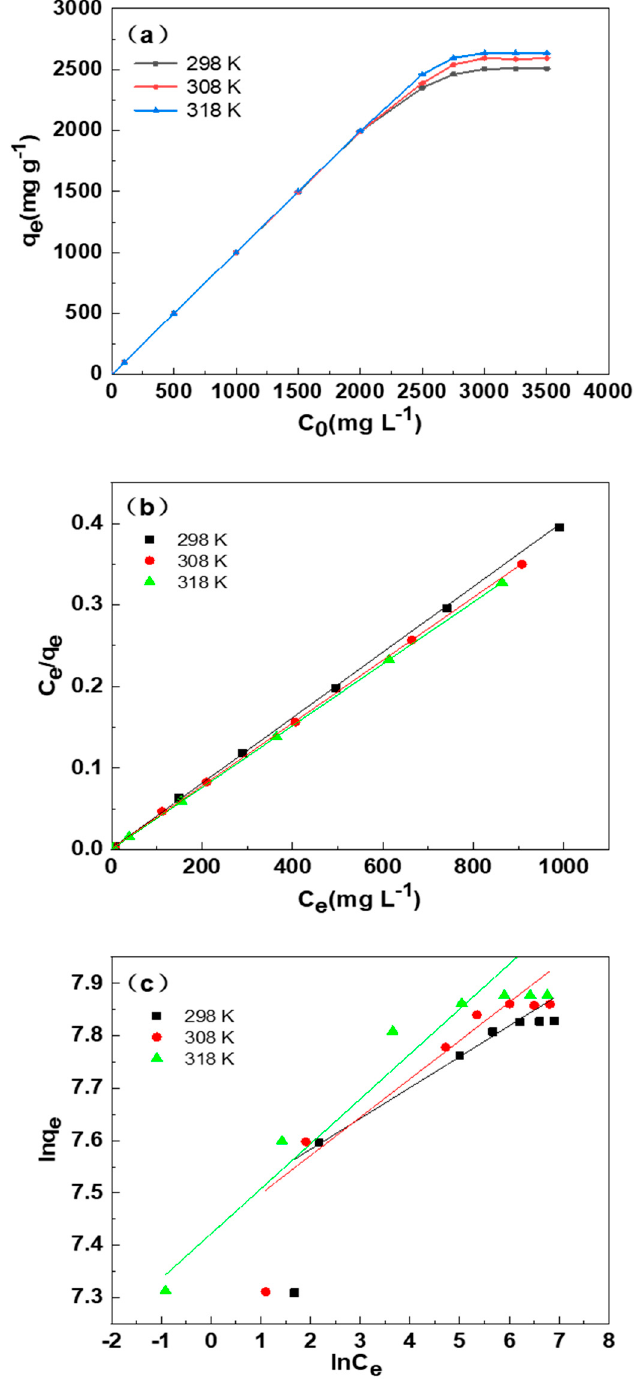
Figure 7 . ( a ) Effect of dye initial concentration and temperature on the adsorption performance. ( b ) The Langmuir isotherms and ( c ) Freundlich isotherms for the MB adsorption by SDB-6-K. Con- ditions: T = 298, 308, 318 K; m = 0.025 g; V = 25 mL; C 0 = 3000 mg L − 1 . Figure 7b,c indicates the fitting of experimental data with the two isotherm models, and the parameters and correlation coefficients of the two models are observed in Table 4. There were higher R 2 values (0.9994, 0.9999, and 1.00) at 298 K, 308 K, and 318 K, respec- 1/T. Both ∆ H and ∆ S were positive values, indicating that the adsorption reaction was tively, in the Langmuir isotherm model, compared with those in the Freundlich isotherm endothermic, and the randomness of the solid-liquid interface during the adsorption model, and thus the Freundlich equation was more suitable for describing the adsorption process increased [41]. In addition, the ∆ H values of the SDB-6-K were greater than of MB on SDB-6-K, indicating that this adsorption process was single-layer adsorption.